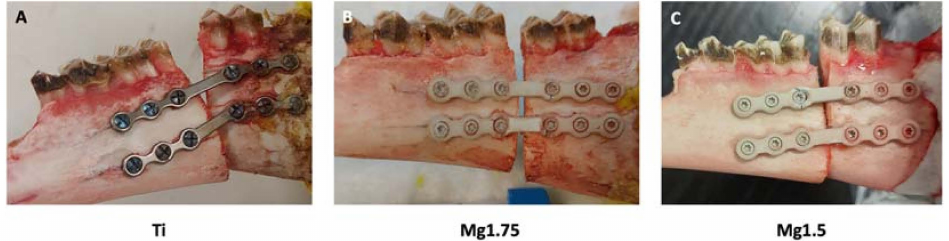
Figure 4. Comparison of plate failure mechanisms. In all cases, a failure of the upper plate occurred. Either the screw proximal from the osteotomy or the screw distal from the osteotomy was identified as the failure location. ( A ) titanium 1.0 mm (Ti) ( B ) magnesium 1.75 mm (Mg1.75) ( C ) magnesium 1.5 mm